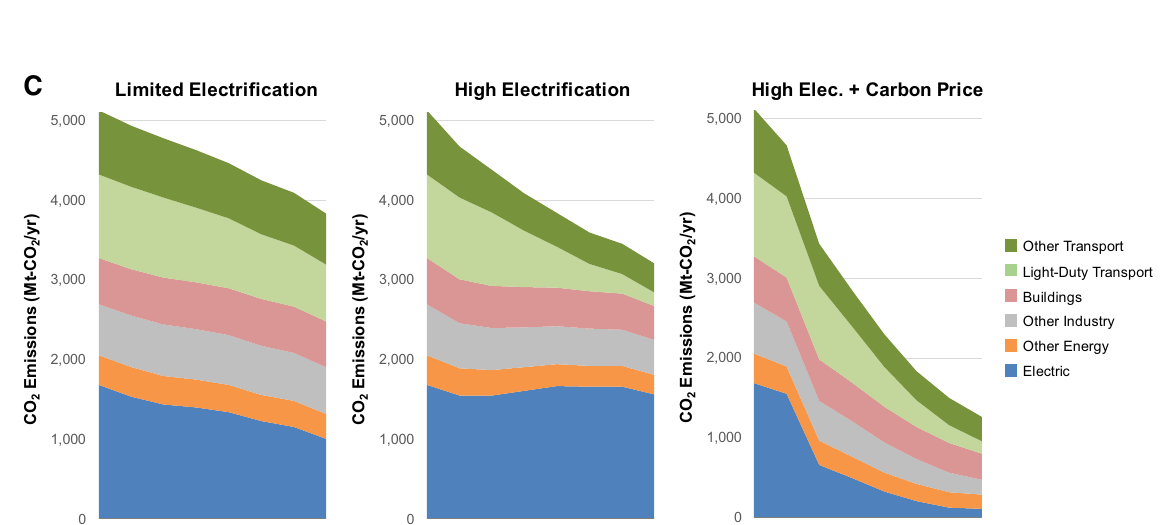
emissions by sector over time (where Other Transport includes all transport other thanlight-dutyvehicles,including bothon-road medium-and heavy-dutytrucksas well as the off- or non-road segments). Results are outputs from the US-REGEN model 41